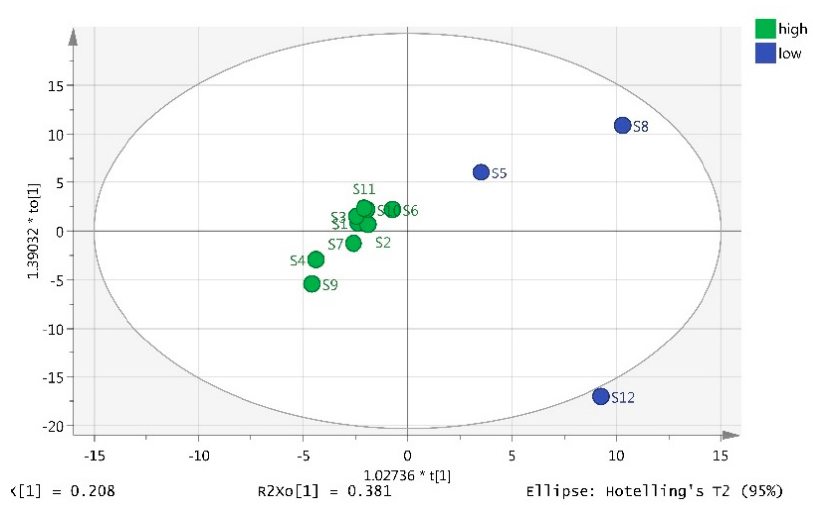
Figure 1. Score plot of OPLS-DA models with the statistical parameters (R2X = 0.208, R2Y = 1.000, Q2 = 0.321) for the classification of Korla pear fruit. High: pear fruit ranked 1–9 in sensory score; Low: pear fruit ranked 10–12 in sensory score.